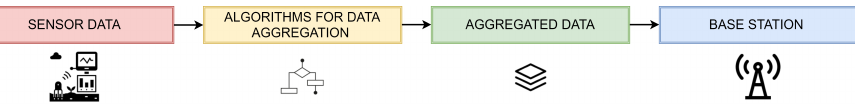
Figure 4. General architecture of data aggregation in wireless sensor